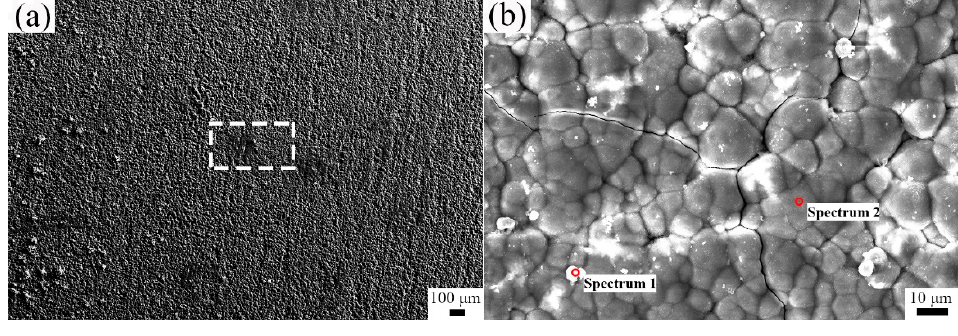
Figure 10. ( a ) SEM image of the corrosion scale of L245N standard steel and ( b ) the enlarged image of the selected area marked in ( a ) after 7 days of testing. Table 6. EDS results of the corrosion scale formed on L245N standard steel after 7 days of testing, (at. %). The spectrum labels correspond to Figure 10b.